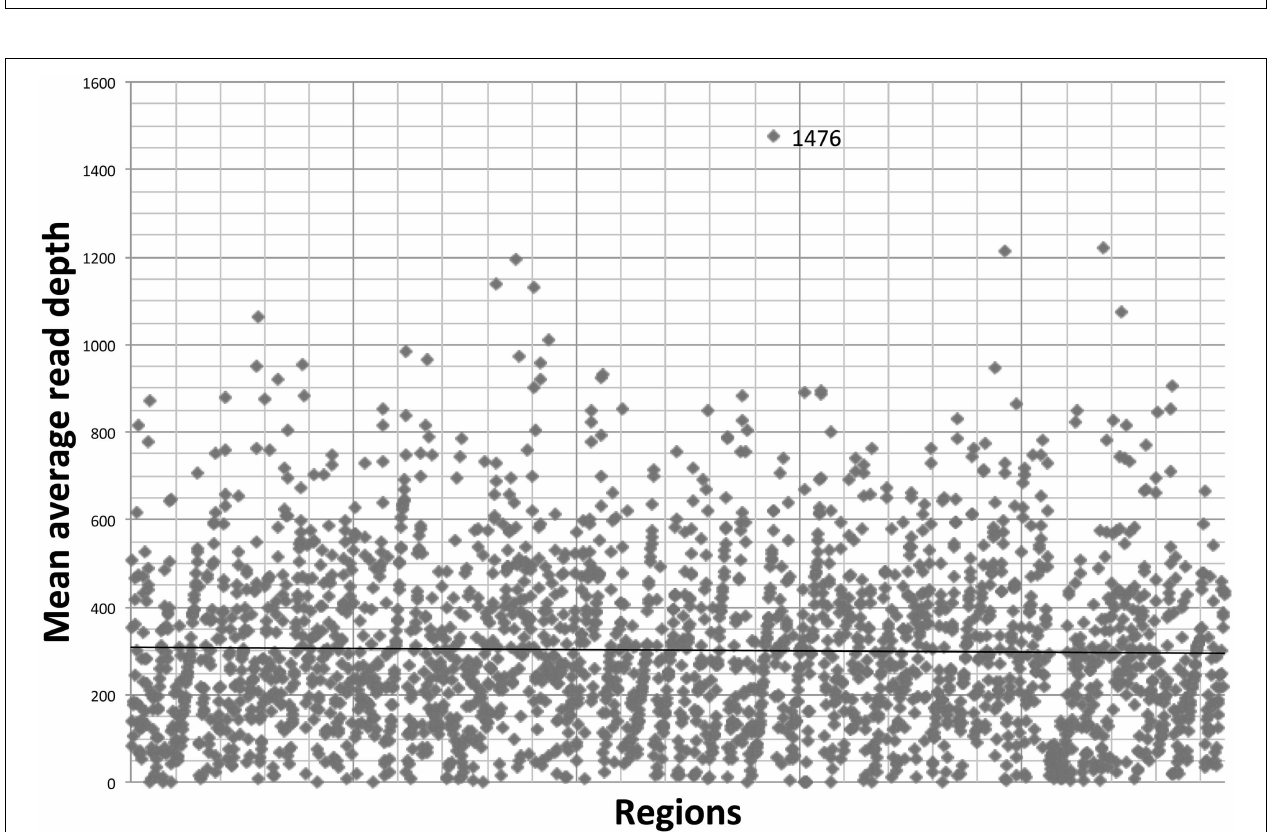
FIGURE 2 | Region-by region coverage analysis for 33 samples run using the default HaloPlex probe hybridization protocol and ion torrent PGM .